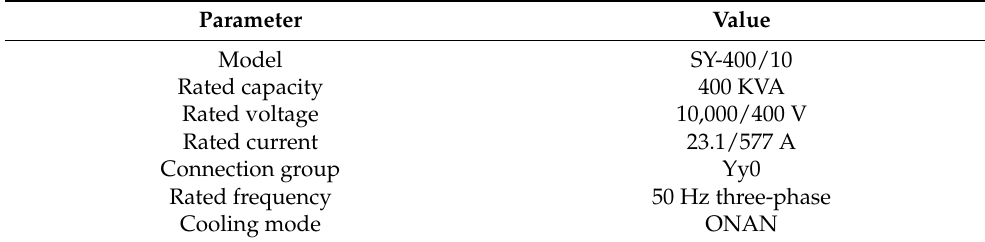
Table 1. Technical parameters of oil-immersed